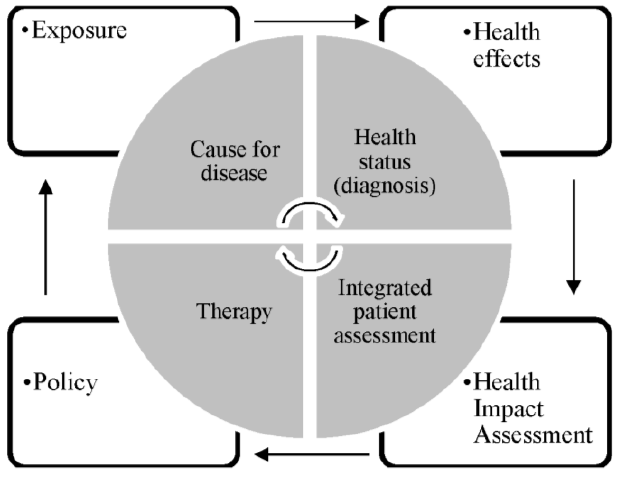
Figure 1. Decision processes in evidence-based medicine and public health (own illustration based on [10]).